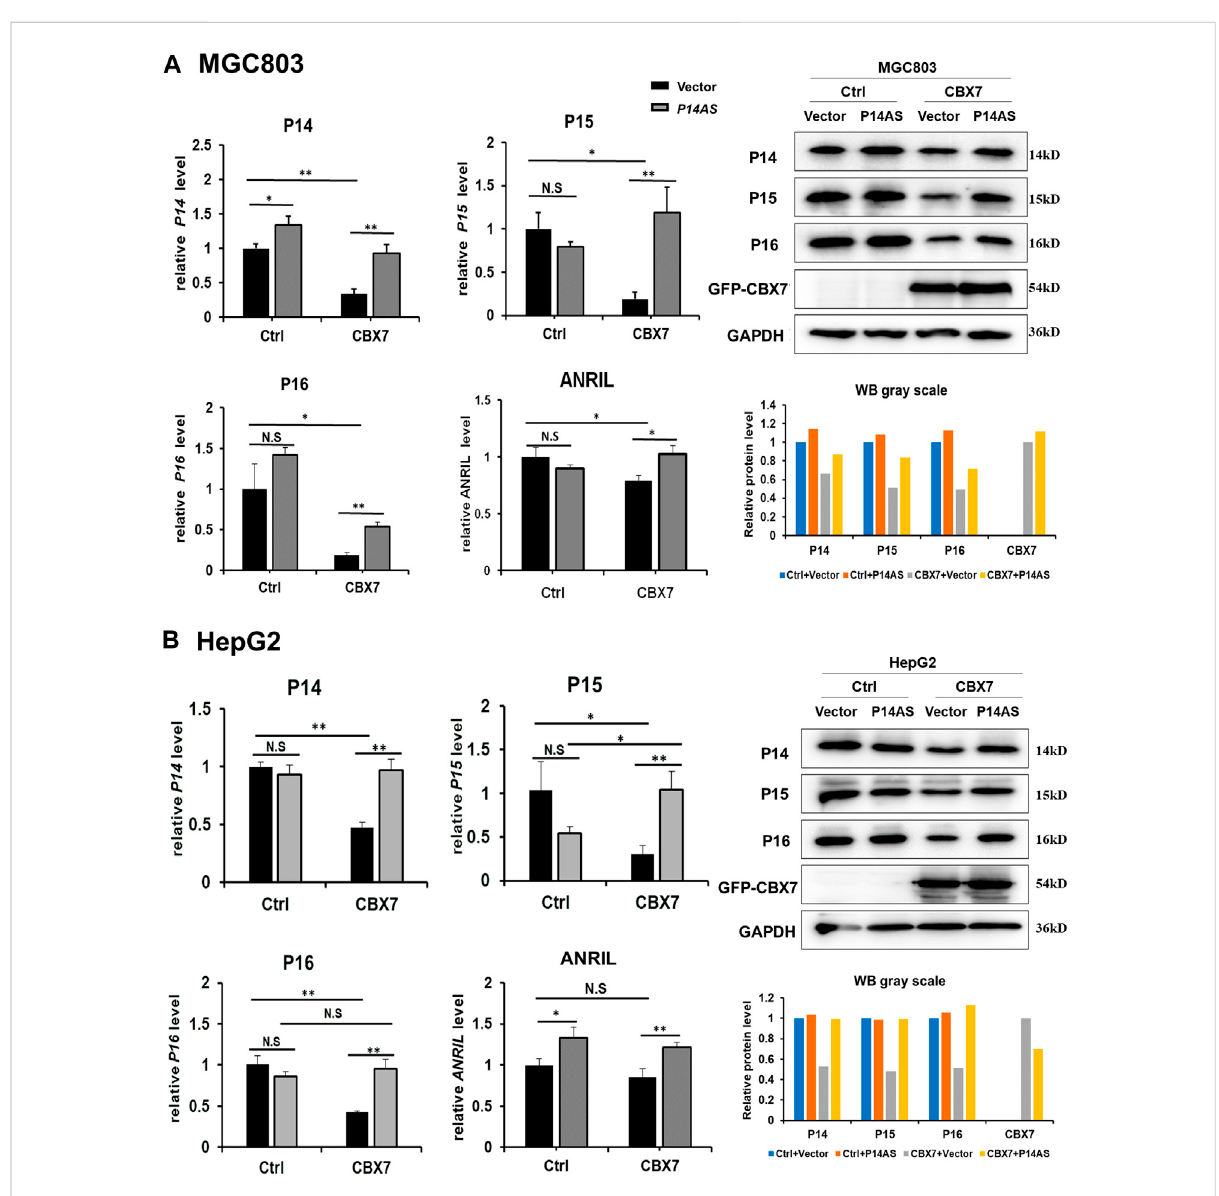
FIGURE 3 Increasing CBX7 expression enables P14AS to upregulate the P14 ARF , P15 INK4B , P16 INK4A expression levels in MGC803 and HepG2 cells with weak basal CBX7 expression in qRT-PCR (left charts for the relative RNA level) and Western blot analyses (right image and chart for the amounts of proteins). (A) MGC803; (B) HepG2 cells.